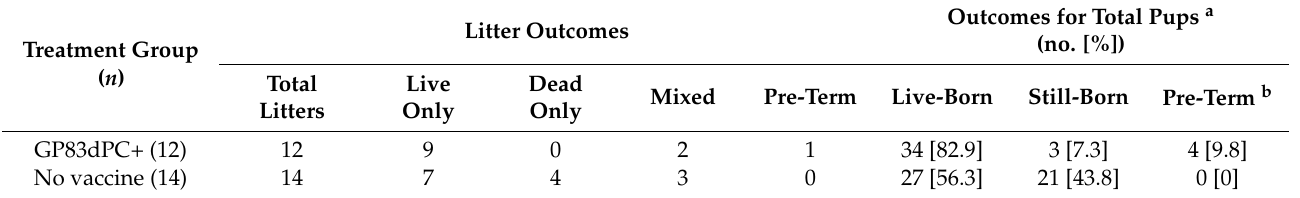
Table 1. Congenital infection outcomes.